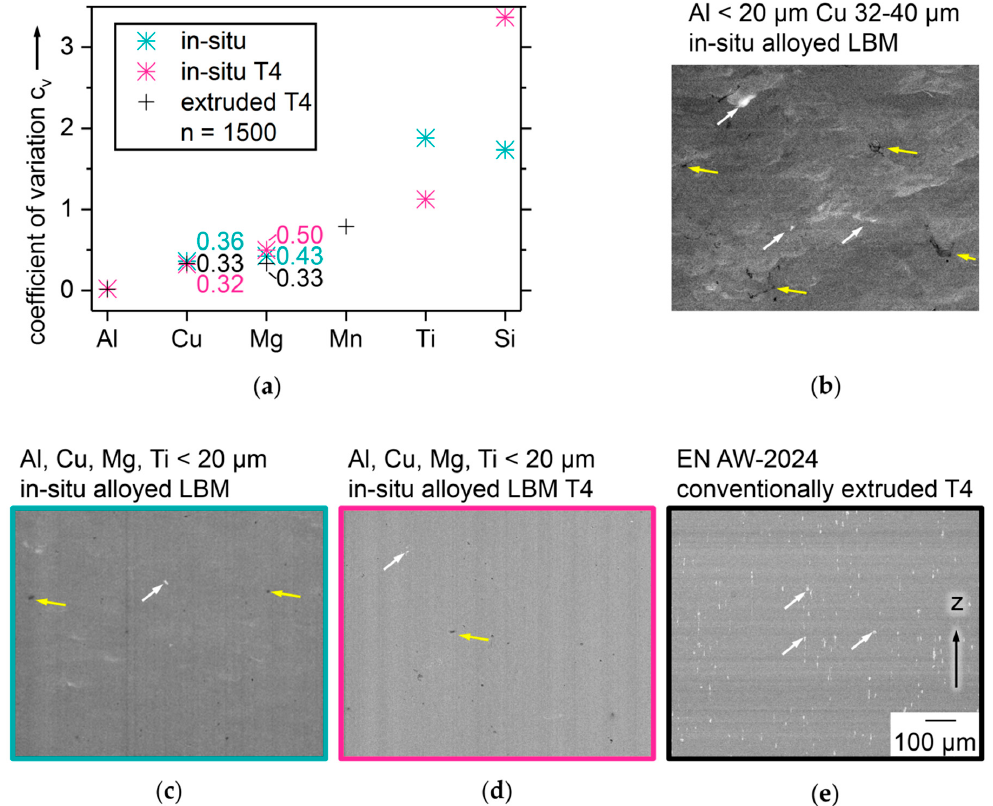
Figure 14. Analysis of chemical homogeneity; ( a ) coefficients of variation C v of elements via EDX comparing in situ alloyed LBM samples made of quaternary Al-Cu-Mg-Ti mixture with particles < 20 µm and SiO x as built and T4 heat-treated to a conventional EN AW-2024 T4 sample; ( b – e ) BSE images of samples; ( b ) LBM of binary Al-Cu, Al particles < 20 µm and Cu 32–40 µm as built; ( c ) quaternary as built; ( d ) quaternary T4; ( e ) EN AW-2024 T4 conventionally manufactured.